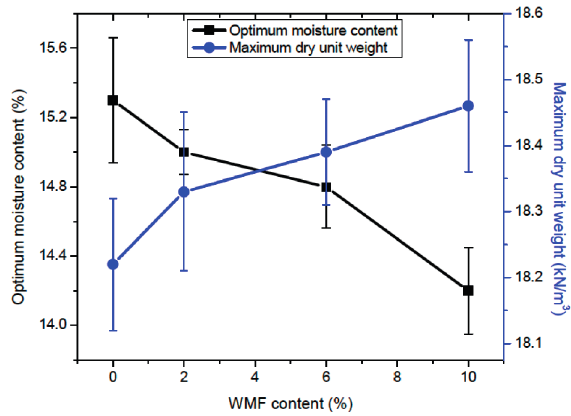
Fig. 6. Variation of compaction characteristics of the treated soil samples with their WMF contents